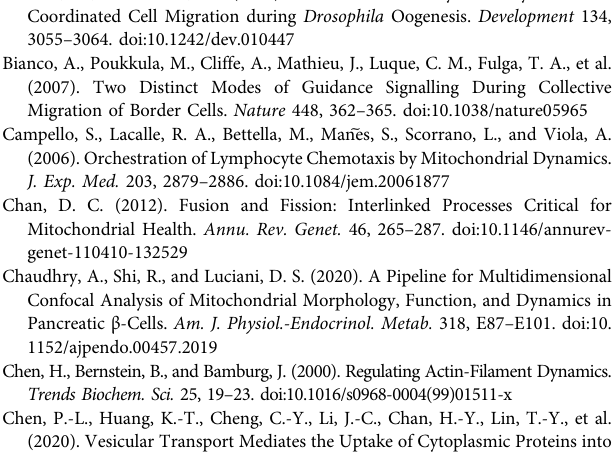
Supplementary Figure S7 | Generation of the Drp1 antibody. (A) Diagram of the fragmentofDrp1thatwasusedtogeneratepolyclonalantibody. (B) LaneM:protein marker; Lane 1: negative control for rDrp1 (without IPTG induction); Lane 2: IPTG induced recombinant Drp1 (rDrp1); Lane 3: puri fi ed rDrp1. (C) The speci fi cantibody detection of endogenous Drp1 from S2 cells. (D) Expressing UAS-Drp1 RNAi and UAS-LacZ (control) in the follicle cells by the Gr1-Gal4 driver. The whole proteins from ovaries were analyzed by SDS-PAGE and Western blot. The preparation of polyclonal antibody was carried out as previously described (Qu et al., 2018). The sequences of Drp1 were ampli fi ed with speci fi c primers (rDrp1-His-F and -R) (Supplementary Table S1). The PCR products were inserted into pET-32a vector with a His-tag. The recombinant plasmid was used to transform E. coli BL21 (DE3) competent cells. The proteins were puri fi ed by a Ni 2+ chelating sepharose column,